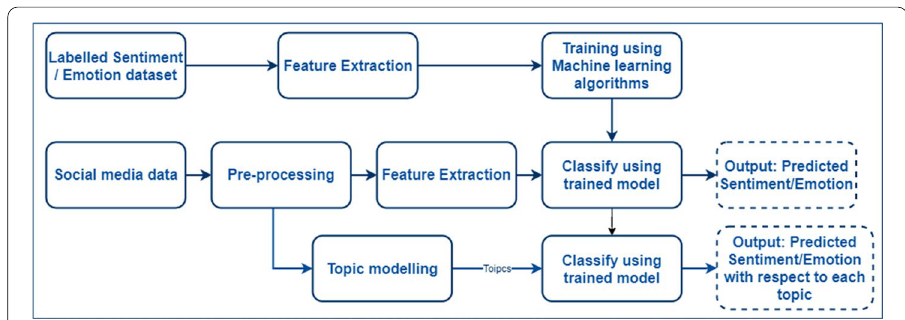
Fig. 1 Sentiment Analysis Methodology